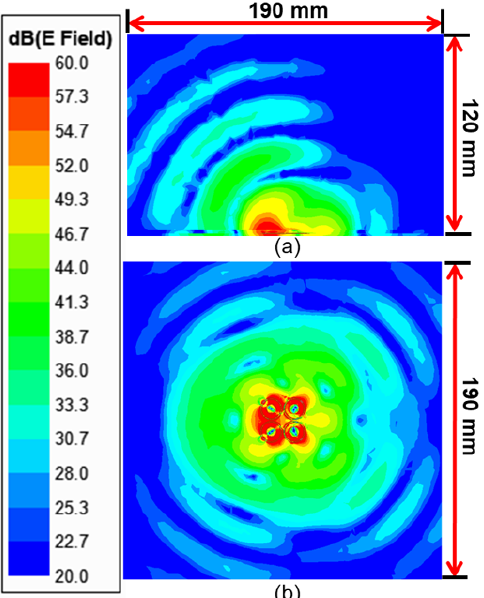
Figure 20. Cross-sections of electric field distributions of the tuned phased array loop resonator with a phase difference of 90 ◦ . ( a ) Side view and ( b ) top view.